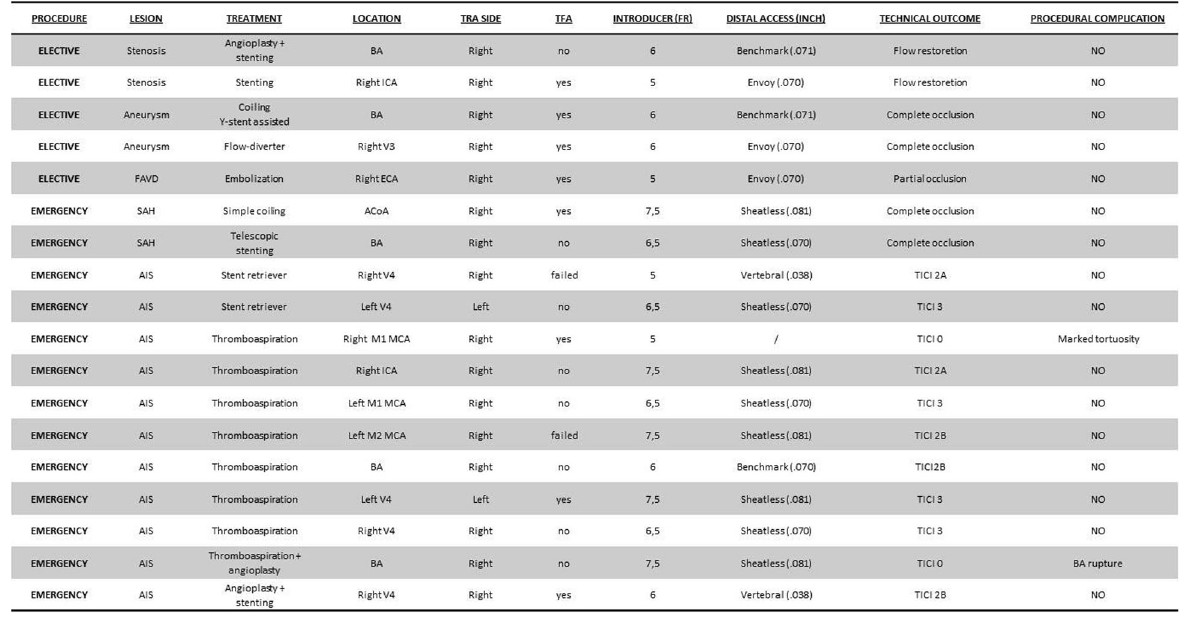
Table 1 Clinical, technical features and complications in the therapeutic group. (Legend: TRA: Trans-radial access; FAVD: Dural Arteriovenous fistula; BA: Basilar Artery; MCA: Middle Cerebral Artery; ACoA: Anterior Communicating Artery; VA: Vertebral Artery; TICI: Thrombolysis in cerebral infarction scale)